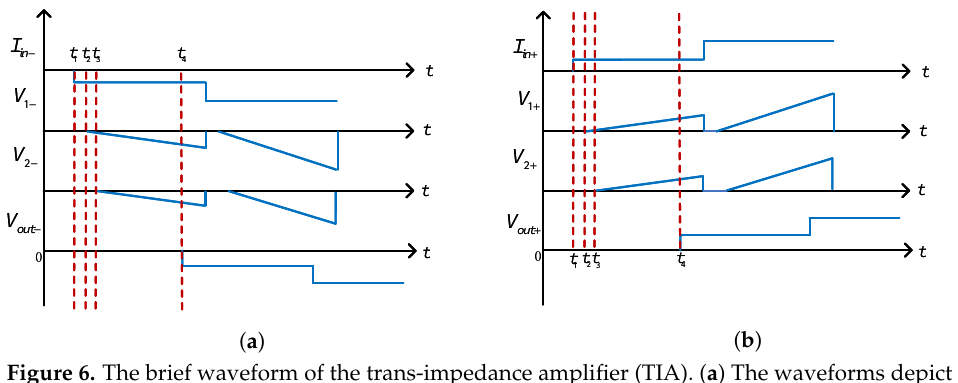
Figure 6. The brief waveform of the trans-impedance amplifier (TIA). ( a ) The waveforms depict the voltage of V 1 − , V 2 − , V out − when the input current is displayed as I in − . ( b ) The waveforms depict the voltage of V 1 + , V 2 + , V out + when the input current is displayed as I in + .